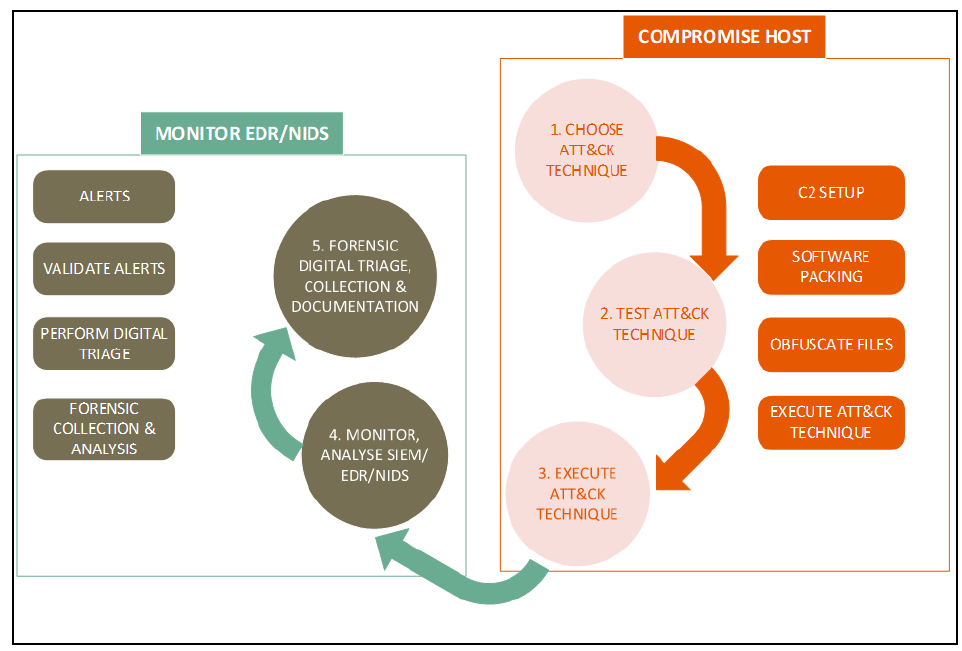
Figure 4. Structured lab testing procedure.